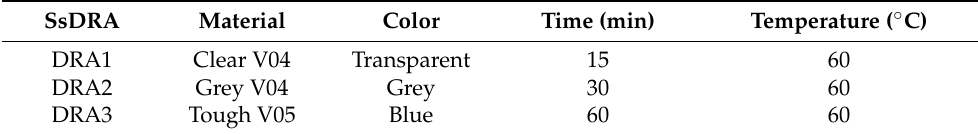
Table 2. UV curing post-processing parameters.